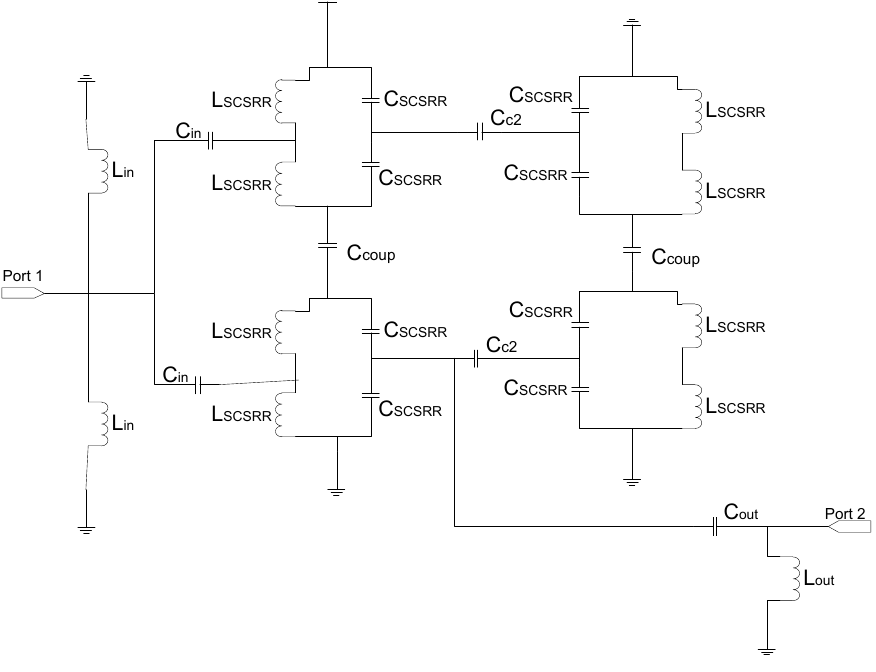
Figure 16. Equivalent circuit model of the two frequency resonators.